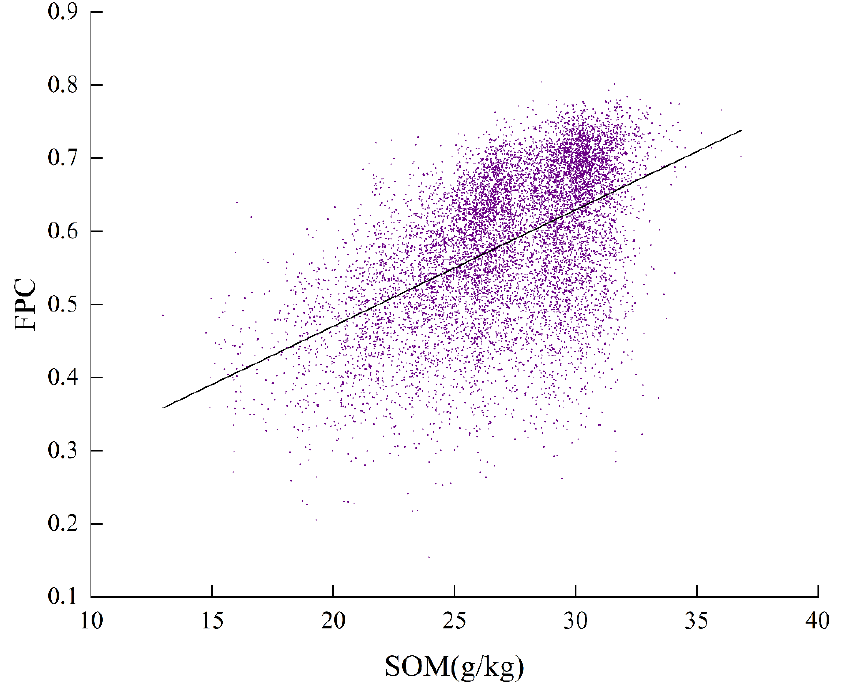
Figure 11. Scatter plot of SOM content and FPC.